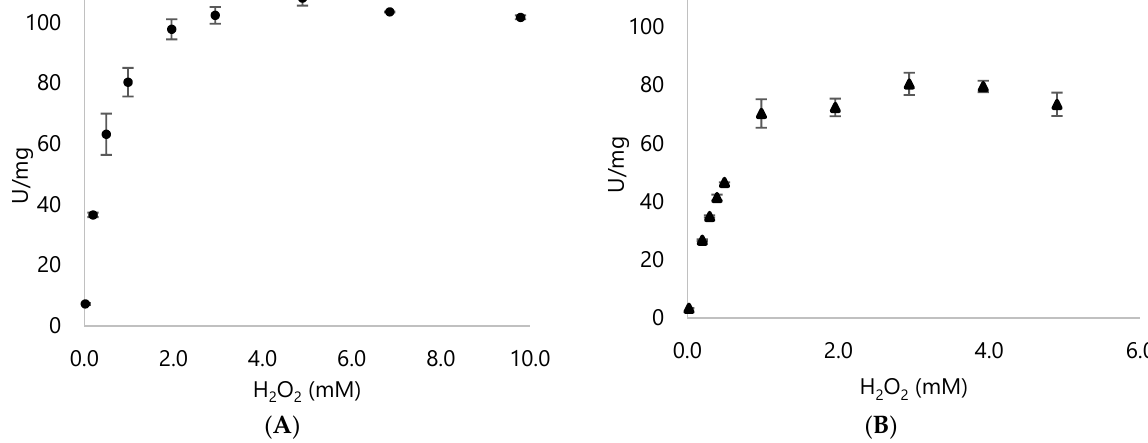
Figure 5. H 2 O 2 profile of the Dyps using the optimal pH and buffer for both Dyps. ( A ) DypA activity in citrate buffer, pH 4.3 ( B ) DypB activity in phosphate buffer, pH 5.0. Different H 2 O 2 concentrations were used and monitored until a decrease in activity can be seen (Table A5).